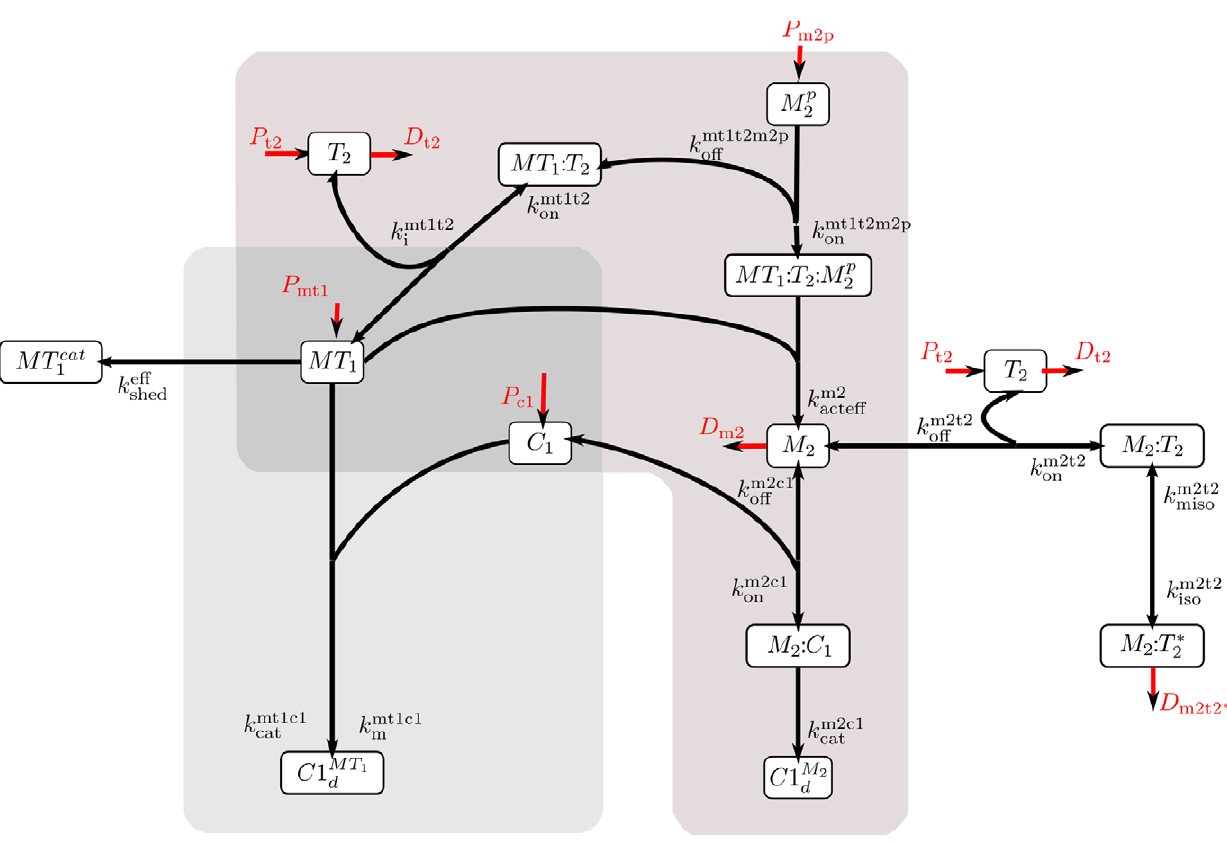
Figure 1. Enzymatic network. In the first part of the Results section, we set the production and degradation parameters to 0 to study the closed system. The different species are described in Table 1. The two concurrent pathways for the degradation of Type I Collagen ( C 1 ) by MT1-MMP ( MT 1 ) and MMP2 ( M 2 ) are highlighted. Notice the ambiguous role of TIMP2 ( T 2 ) in both of these pathways.